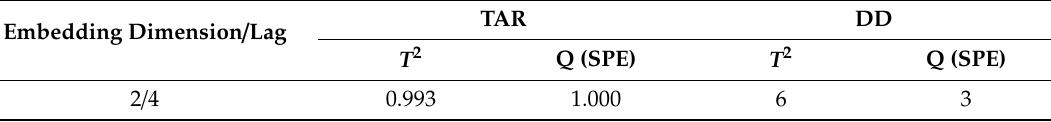
Table 11. Monitoring AG mill operational state using Method III. Embedding Dimension /